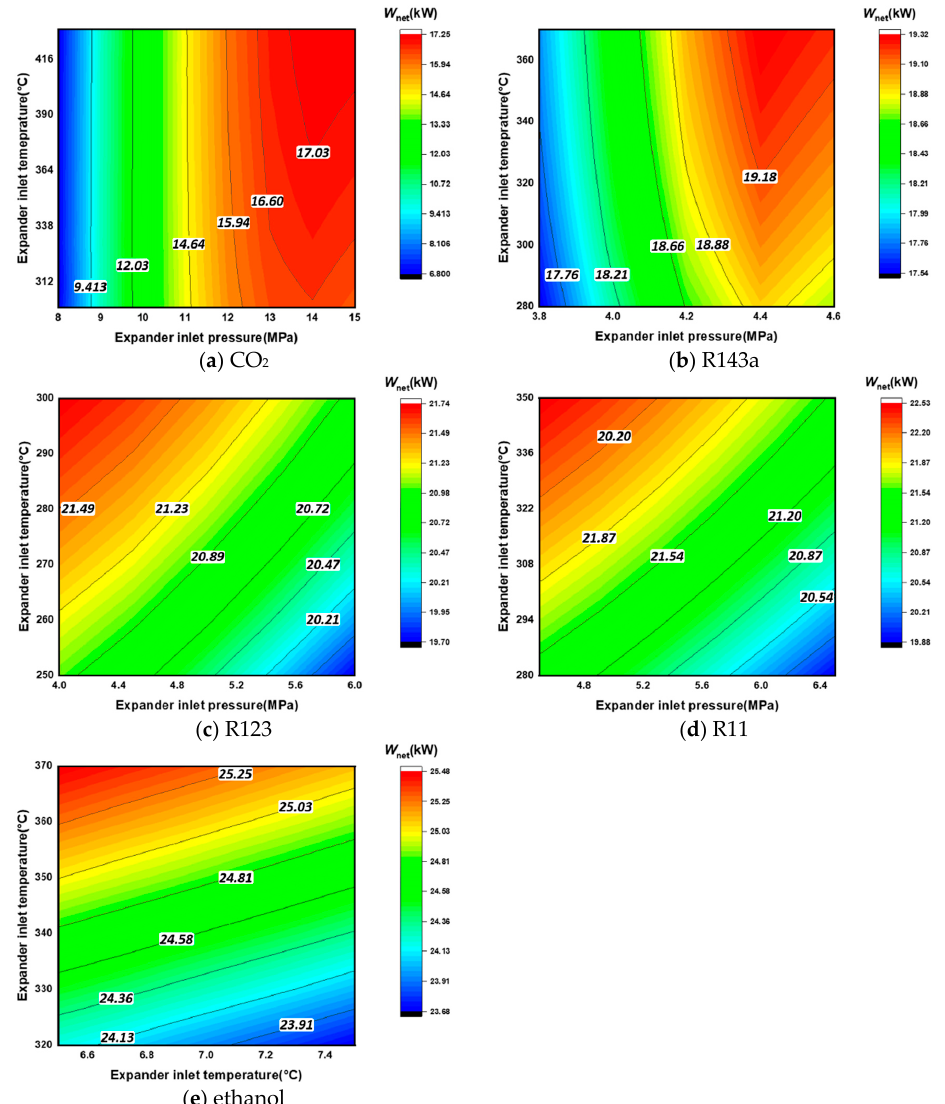
Figure 6. Effect of the expander inlet pressure and temperature on the net power output : ( a ) CO 2 , ( b ) Figure 6. E ff ect of the expander inlet pressure and temperature on the net power output: ( a ) CO 2 , R143a, ( c ) R123, ( d ) R11, and ( e ) ethanol. ( b ) R143a, ( c ) R123, ( d ) R11, and ( e )